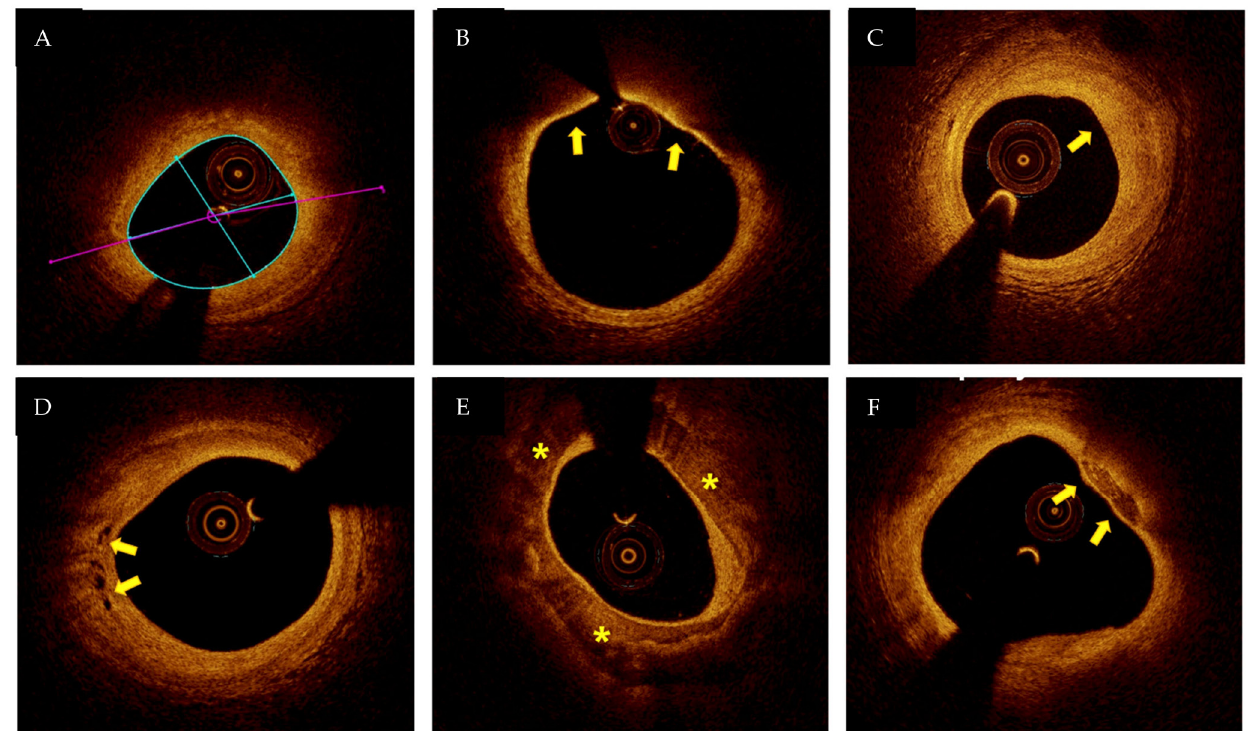
Figure 1. OCT (optical coherent tomography image): ( A ) lipid-rich plaque; ( B ) thin-cap fibroatheroma (arrows); ( C ) fibrous plaque (arrow); ( D ) neovascularization (arrows); ( E ) calcification (asterisks); ( F ) spotty calcium (arrow). Figure from authors’ library.